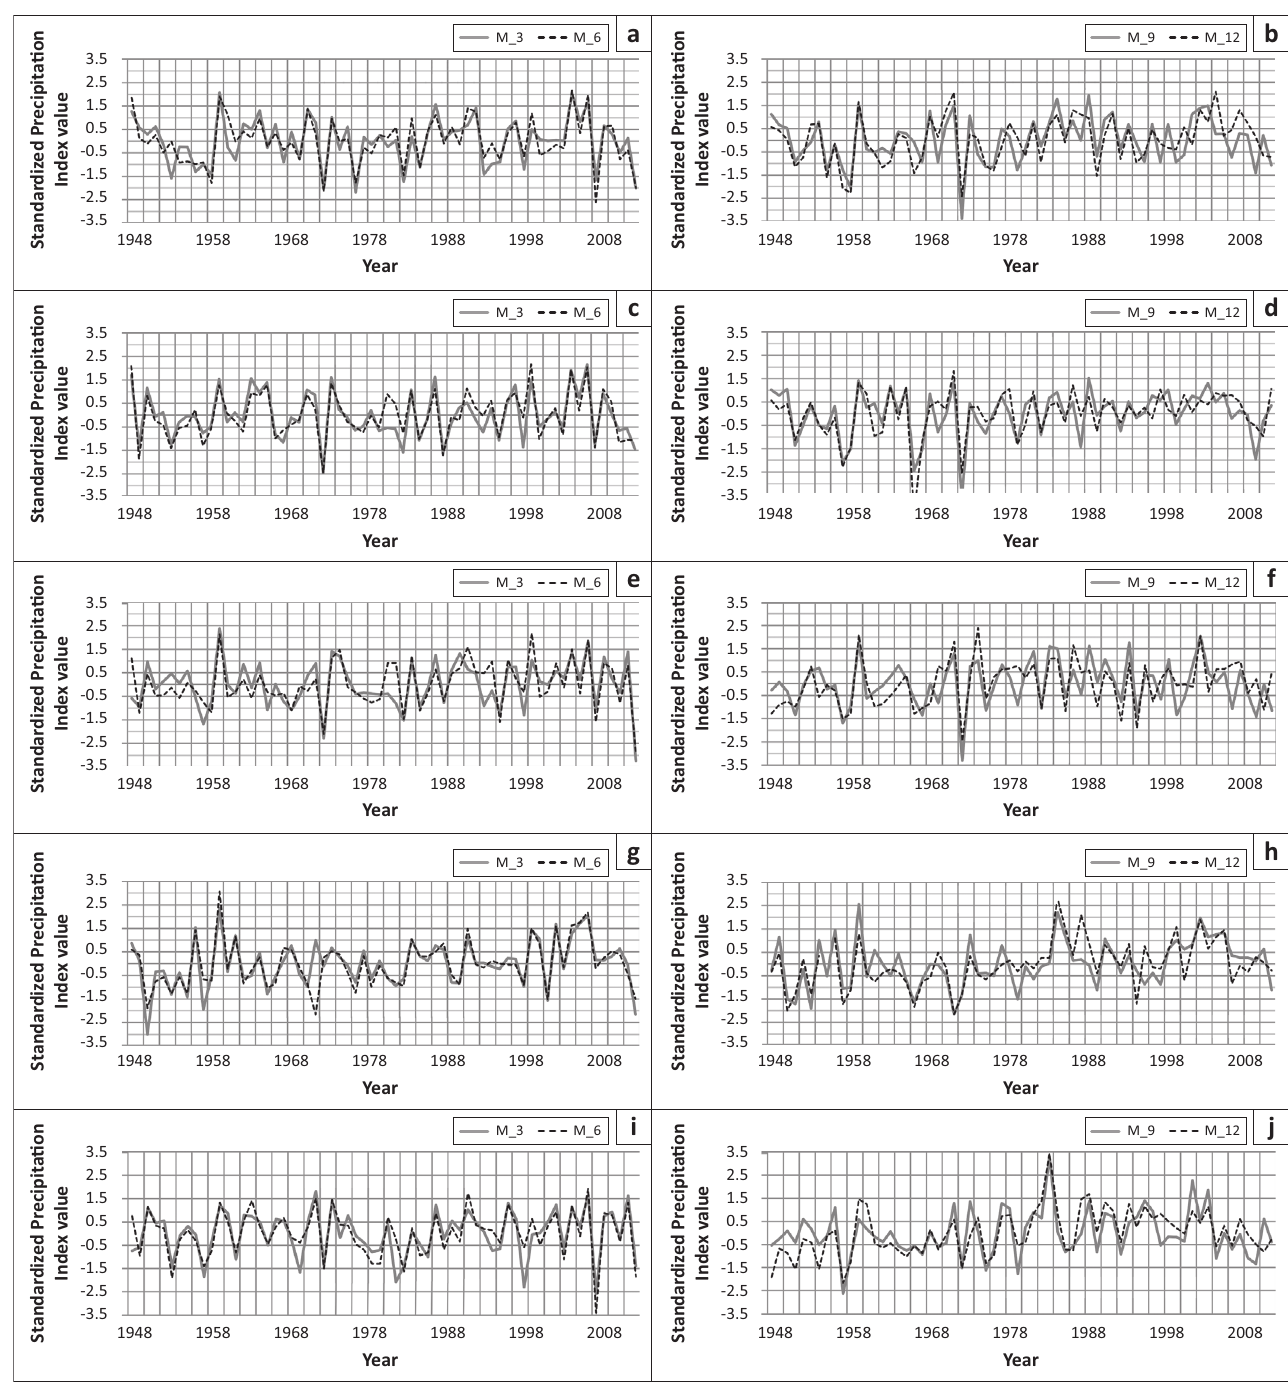
FIGURE 3: Drought in (a) Jessore, (c) Satkhira, (e) Khulna, (g) Barisal, (i) Patuakhali, (k) Bhola, (m) Hatyia, (o) Khepupara, (q) Maizdi Court and (s) Sandwip based on 3-month SPI (M_3) and 6-month SPI (M_6). Drought in (b) Jessore, (d) Satkhira, (f) Khulna, (h) Barisal, (j) Patuakhali, (l) Bhola, (n) Hatyia, (p) Khepupara, (r) Maizdi Court and (t) Sandwip based on 9-month SPI (M_9) and 12-month (annual) SPI (M_12).